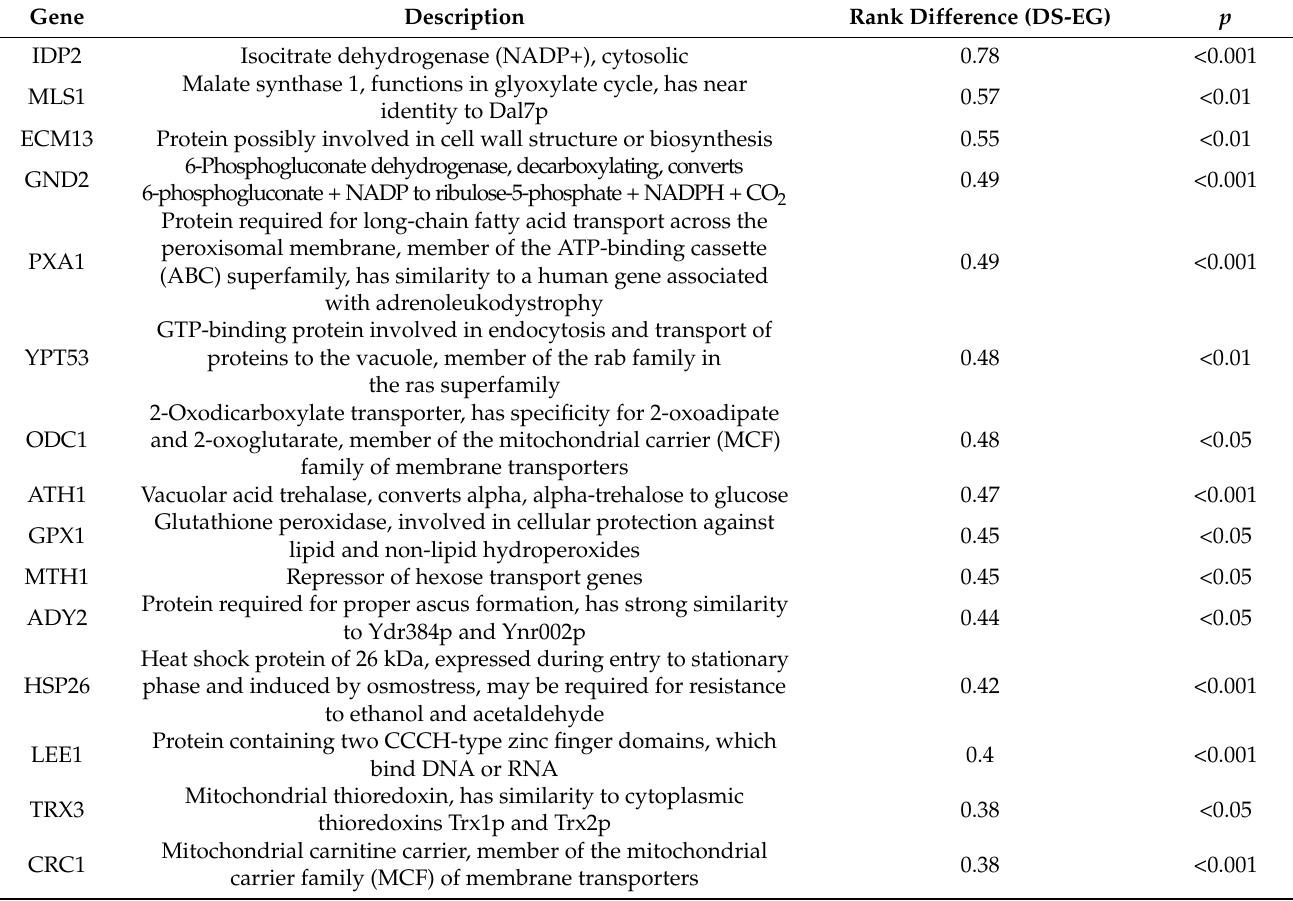
Table 2. Genes involved in the change of metabolism imposed by